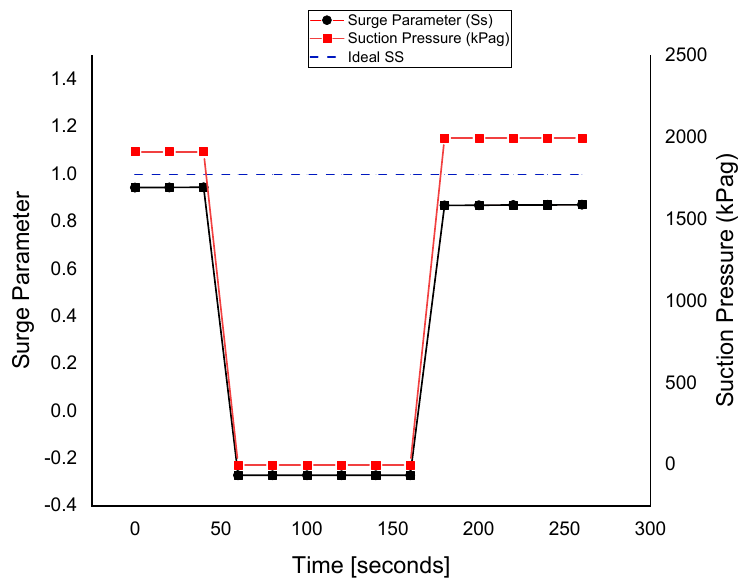
Figure 11. The fault tolerance in the suction pressure sensor.